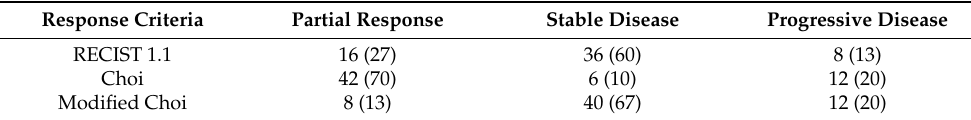
Table 2. Response categorization of patients after two treatment cycles.